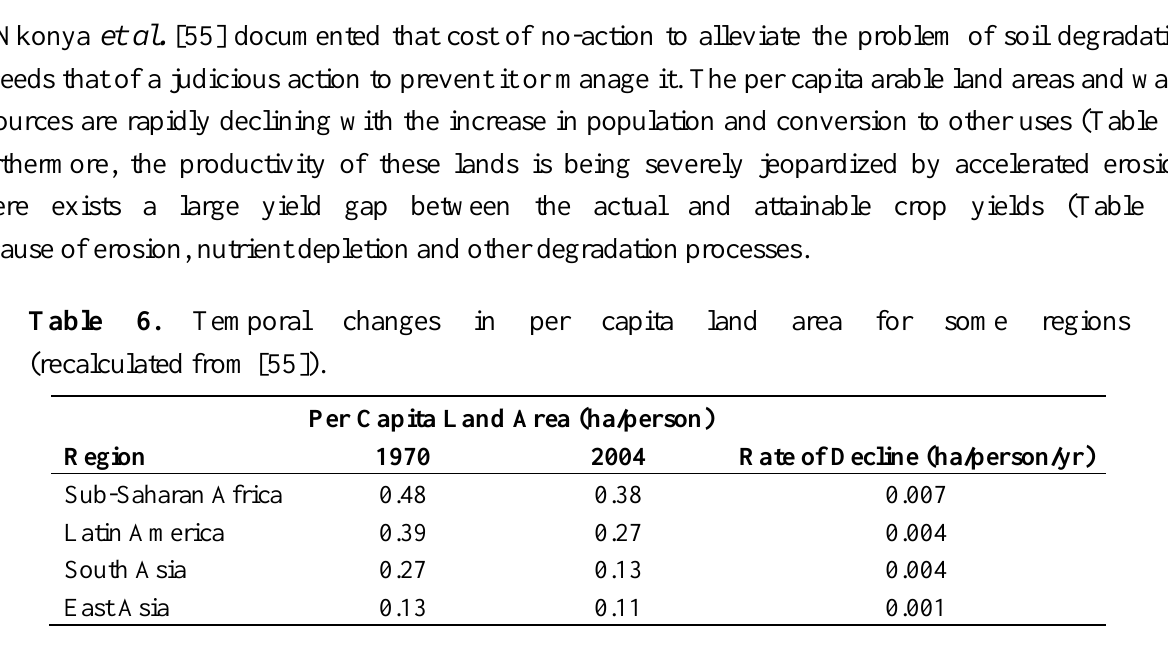
Table 5. Global estimates of land degradation between 1981 and 2003 (recalculated from [45]). Region # of Countries Degrading Area (10 6 km 2 ) Affected People in 2008 (10 6 ) Sub-Saharan Africa 44 6.4 196 Central Asia 6 0.5 4 South Asia 8 0.8 274 East Asia 5 2.4 512 Southeast Asia 10 2.4 228 The Caribbean 8 0.3 12 Central America 8 1.1 45 Latin America 10 0.6 128 World 10 35.1 1,538 Note: Mexico is included in both Latin America and Central America.